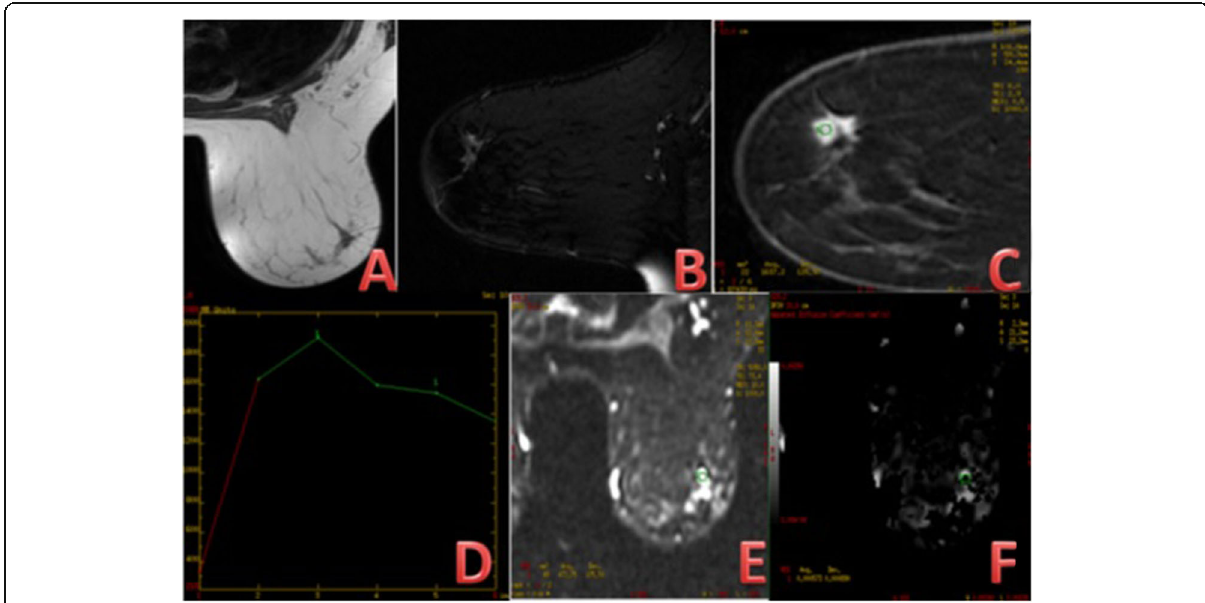
Fig. 1 52-year-old women, grade I invasive ductal carcinoma, ER (+), PR ( − ) c-erb B2 (+), high Ki-67 index, and no axillary pathological lymph node detected on MRI. Breast density is classified as type a on T1WI axial image ( a ). An irregular shaped lesion, measured 15 mm in diameter, is seen on sagittal fat-saturated T2WI ( b ) and sagittal fat-saturated, post-contrast T1WI ( c ). Kinetic curve of the lesion is type 3 and t peak value is 100 s ( d ). The lesion is hyperintense on DWI ( e ) and hypointense on ADC map ( f )